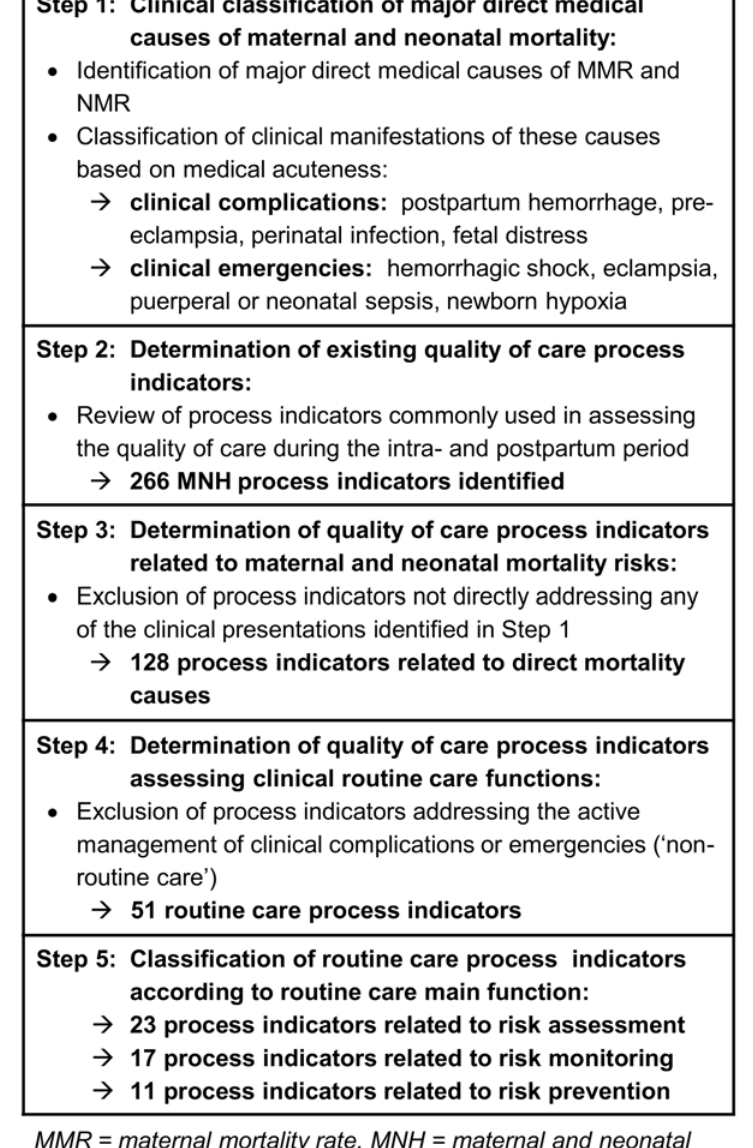
Fig 2. Overview of the steps leading to the selection of routine MNH care process